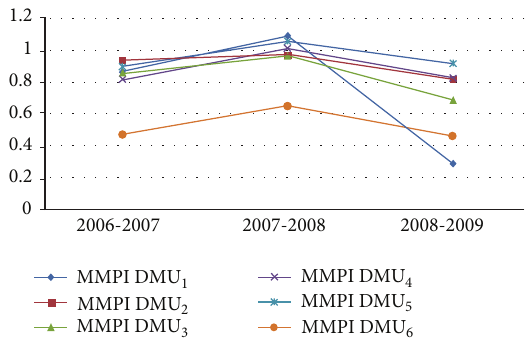
Figure 2: Modified Malmquist Productivity Index.